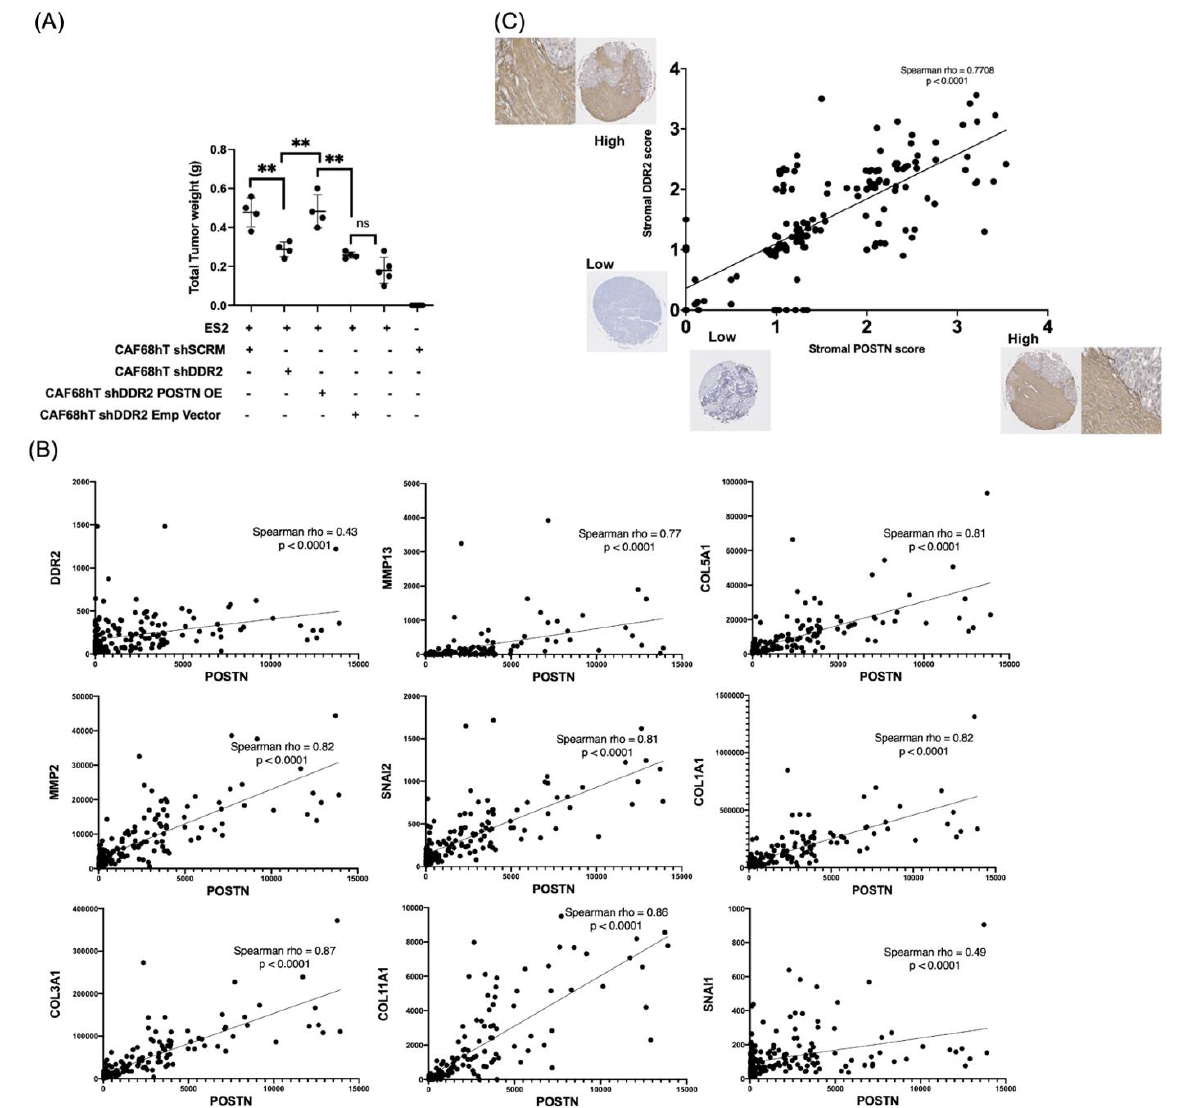
Figure 6. DDR2 and POSTN promote in vivo tumor implantation. ( A ) Xenograft model showing increased tumor burden in mice co-injected with DDR2-depleted, POSTN-overexpressing CAFs and ES2 tumor cells. ( B ) Correlation between POSTN mRNA expression and DDR2 (and known ligands/targets) mRNA expression using TCGA data, and ( C ) Tumor microarray IHC data showing correlation between POSTN protein expression and DDR2 protein expression. ** p < 0.01.